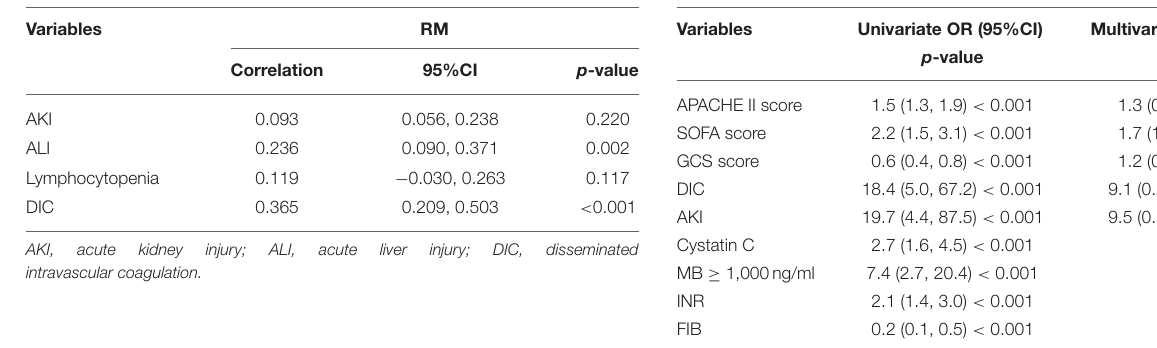
TABLE 4 | Risk factors for 90-day mortality with RM induced by